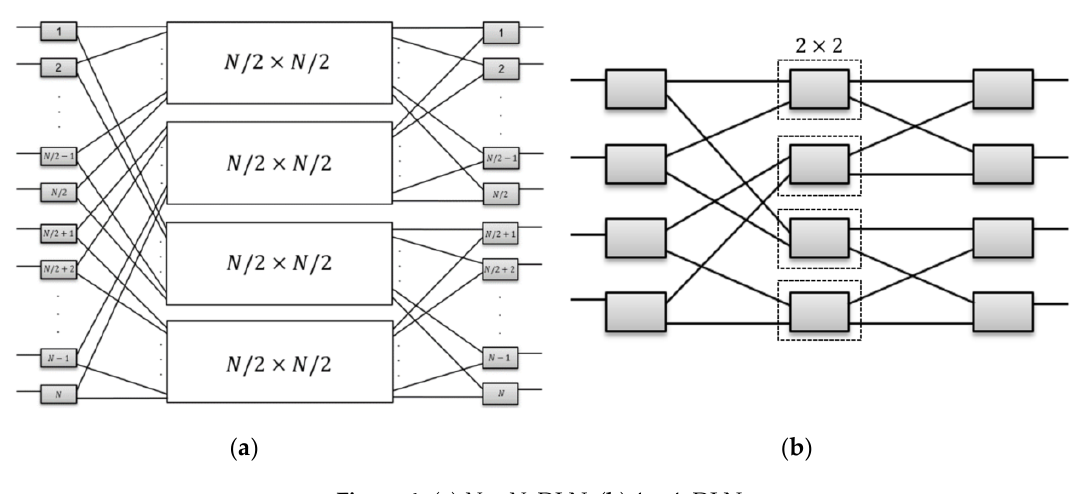
Figure 4. ( a ) (cid:1840) × (cid:1840) − DLN, ( b ) 4 × 4 − DLN .